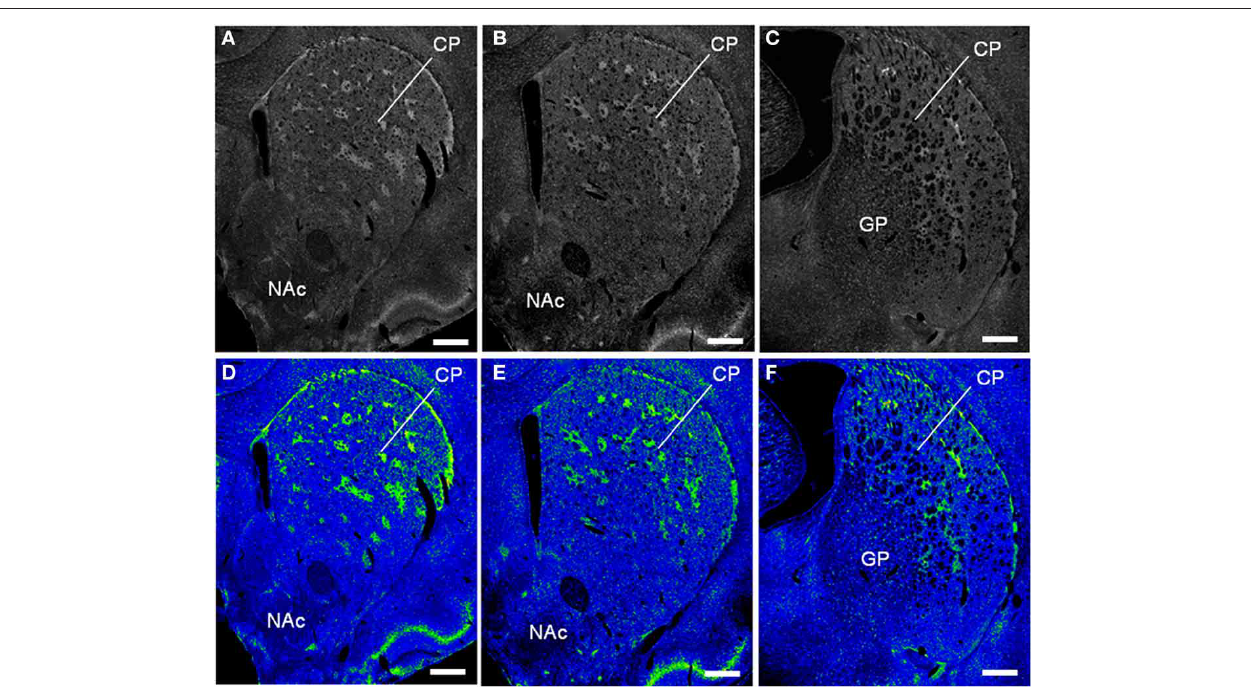
FIGURE 3 | Striatal patches identified by DOR-immunostaining in the rat striatum. The frontal sections from anterior to posterior of the striatum labeled for DOR (A–C) and their color-converted images (D–F) . CP, caudate-putamen; NAc, nucleus accumbens; GP; globus pallidus. Scale bars = 500 μ m.